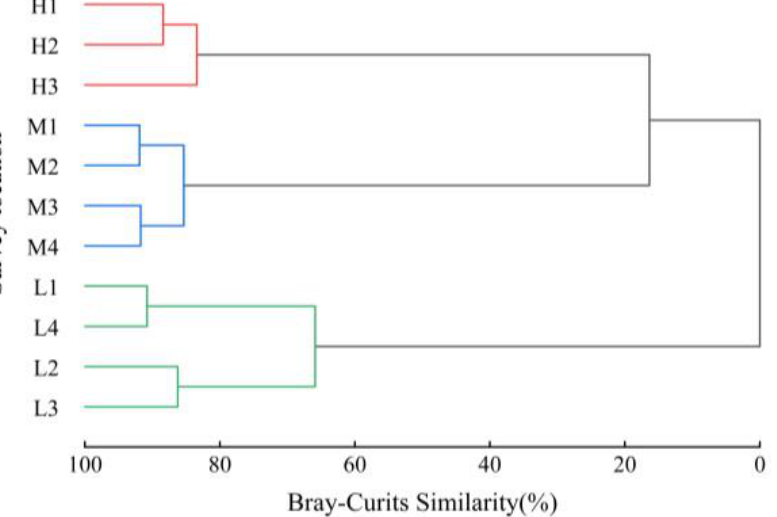
Figure 2. Dendrogram for the hierarchical clustering of macrobenthic communities at different survey sites. H1 – H3, M1 – M4, and l1 – l4 indicate the survey locations in the Euryale ferox artificial planting area (type H), Trapa spp. natural growth area (type M), and control area (type L), respec- tively.